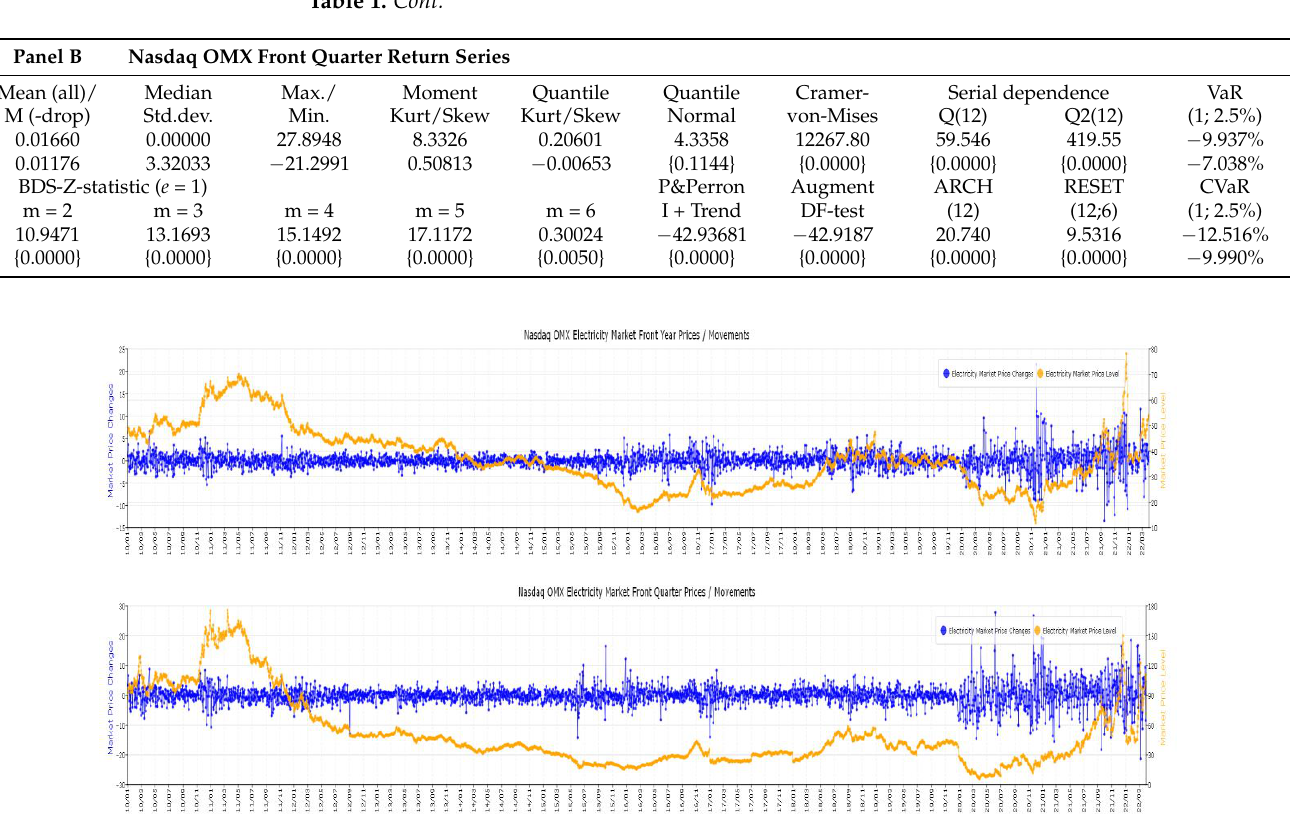
Table 1. Nordic/Baltic Electricity Market Characteristics, 2010 – 2022.